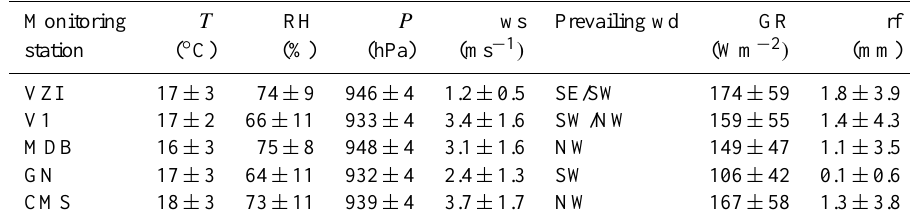
Table 2. Mean ± standard deviation ( m ± SD) of the main meteorological parameters measured at the five air quality monitoring stations from 1 September to 31 October 2013. Regarding the wind direction (wd), the prevailing directions evaluated for the entire period of observation are